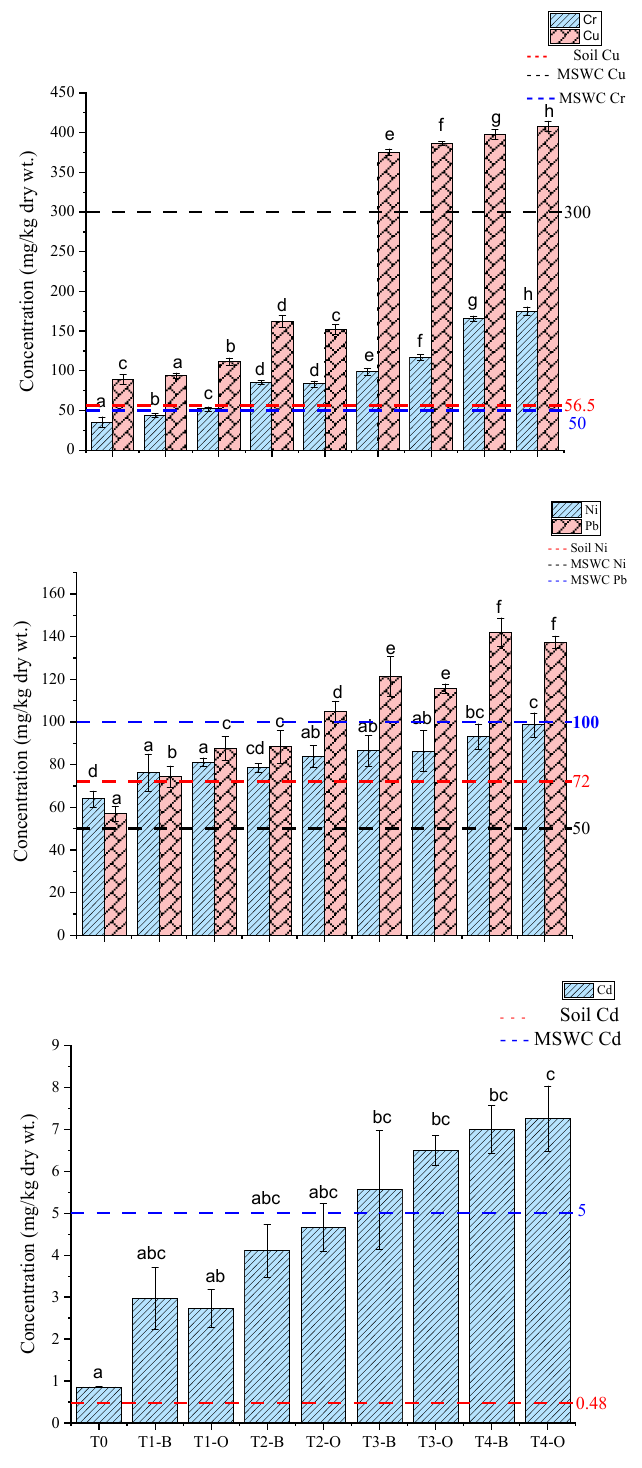
Figure 2. Available heavy metal contents of the soil samples with increased dosage of MSWC. Means with different letters are significantly different at p < 0.05. Each point represents the mean of three replicates, and the error bars represent the standard deviation.